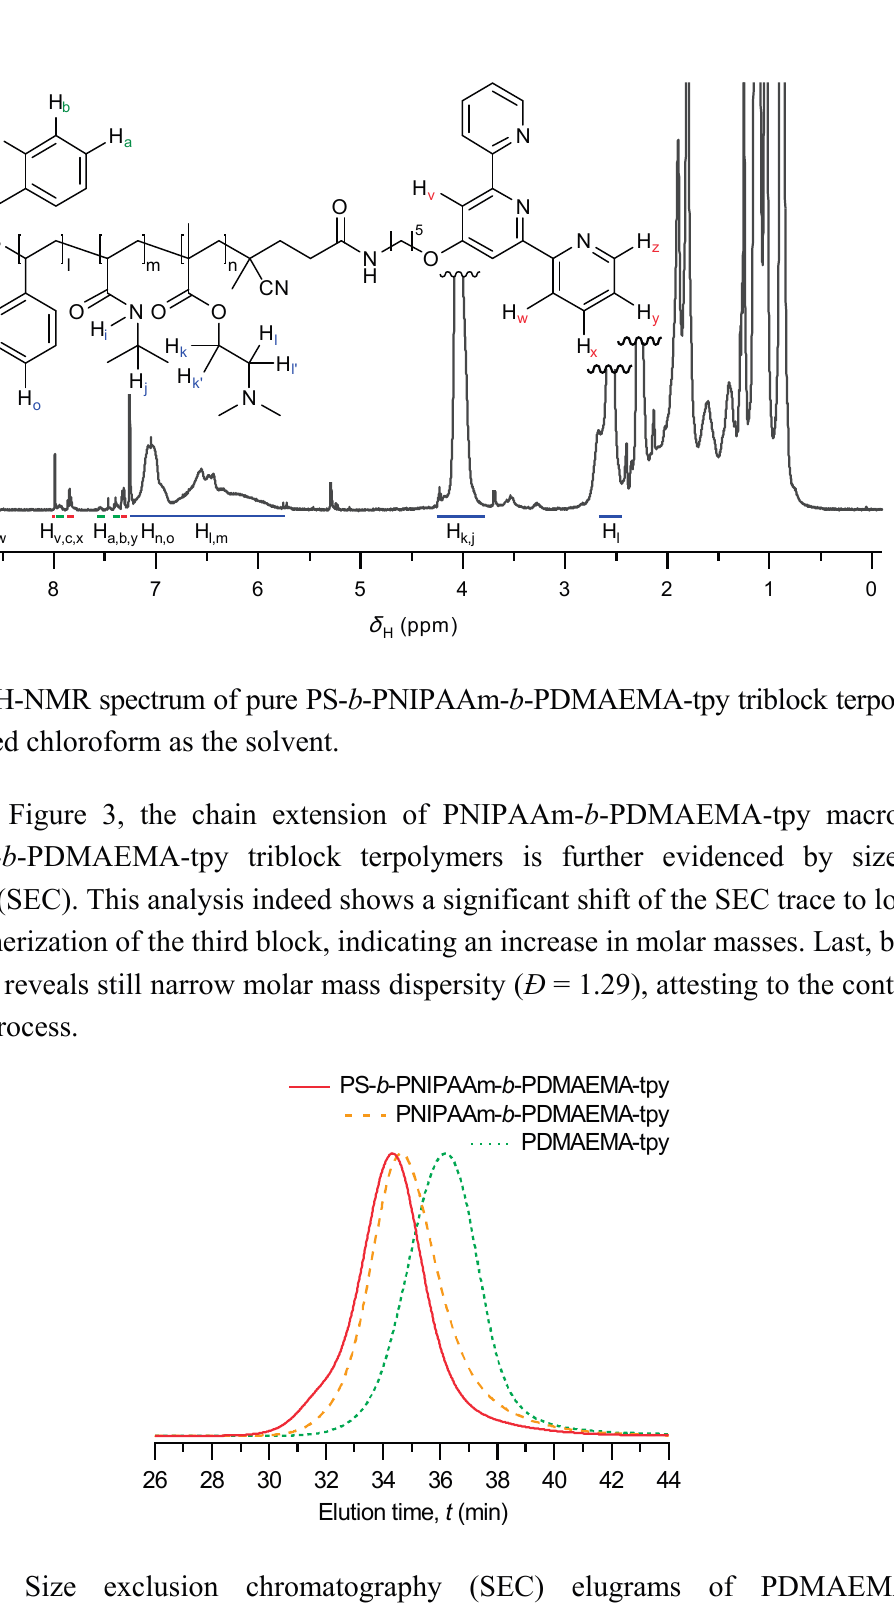
Figure 3. Size exclusion chromatography (SEC) elugrams of PDMAEMA-tpy homopolymer, derived PNIPAAm- b -PDMAEMA-tpy diblock copolymer and PS- b - PNIPAAm- b -PDMAEMA-tpy triblock